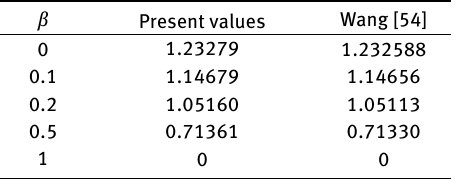
Table 2: Comparison between the present analytical results and published results of f (cid:48)(cid:48) (0, ξ ) for M = 0, ξ = 1 (steady state), α = λ 1 = λ 2 = 0 .